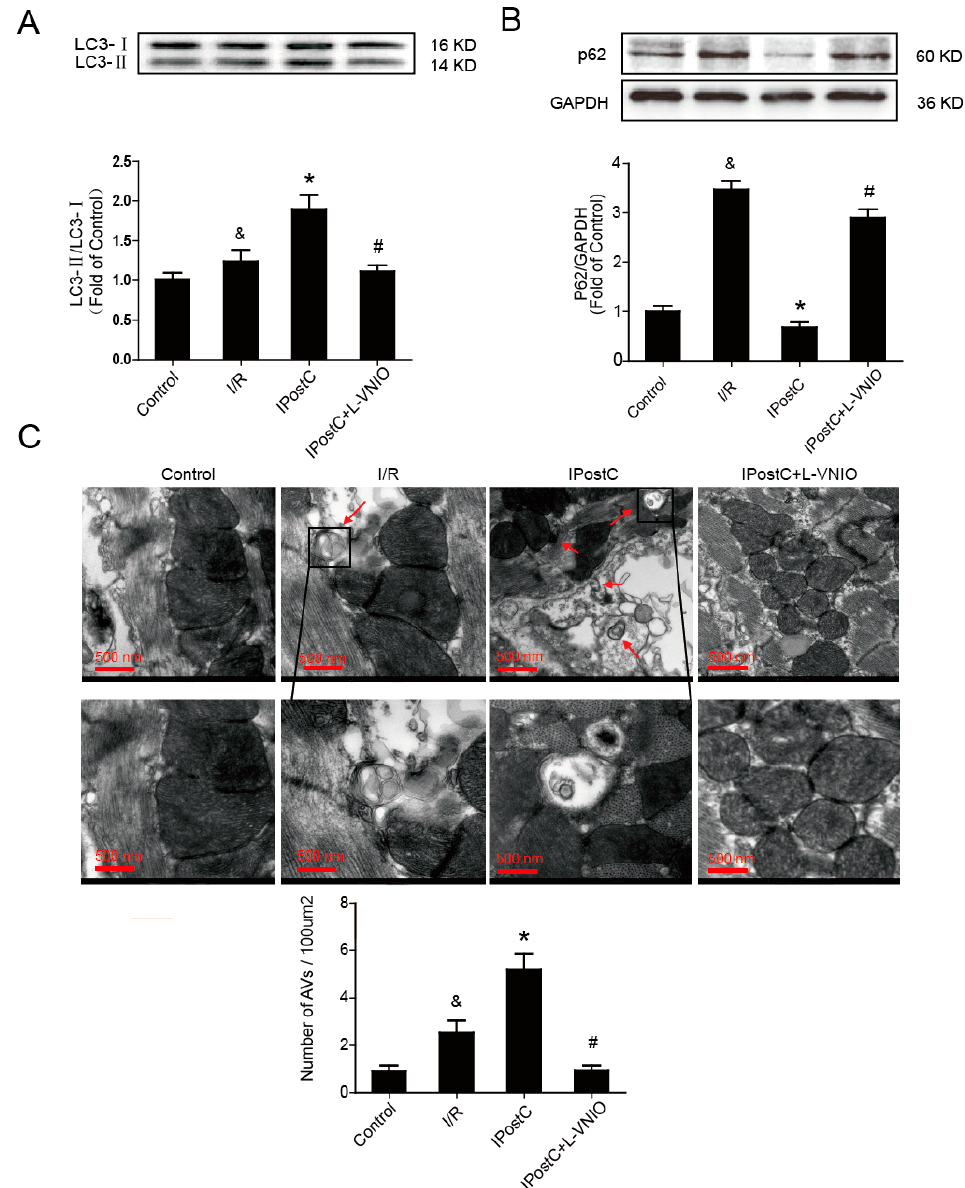
Figure 2. Autophagy activity was promoted by IPostC via nNOS in myocardium. ( A ) The protein expression of LC3 in the myocardium at 30 min of reperfusion; ( B ) The level of p62 was detected in the myocardium; ( C ) Autophagosomes (AVs) which were marked with red arrows were confirmed using electron microscopy in the control, I/R, IPostC group and IPostC treated with nNOS inhibitor L-VNIO. & p < 0.05 versus control, * p < 0.05 versus I/R, # p < 0.05 versus IPostC. The mean values ± SEM, n = 6.